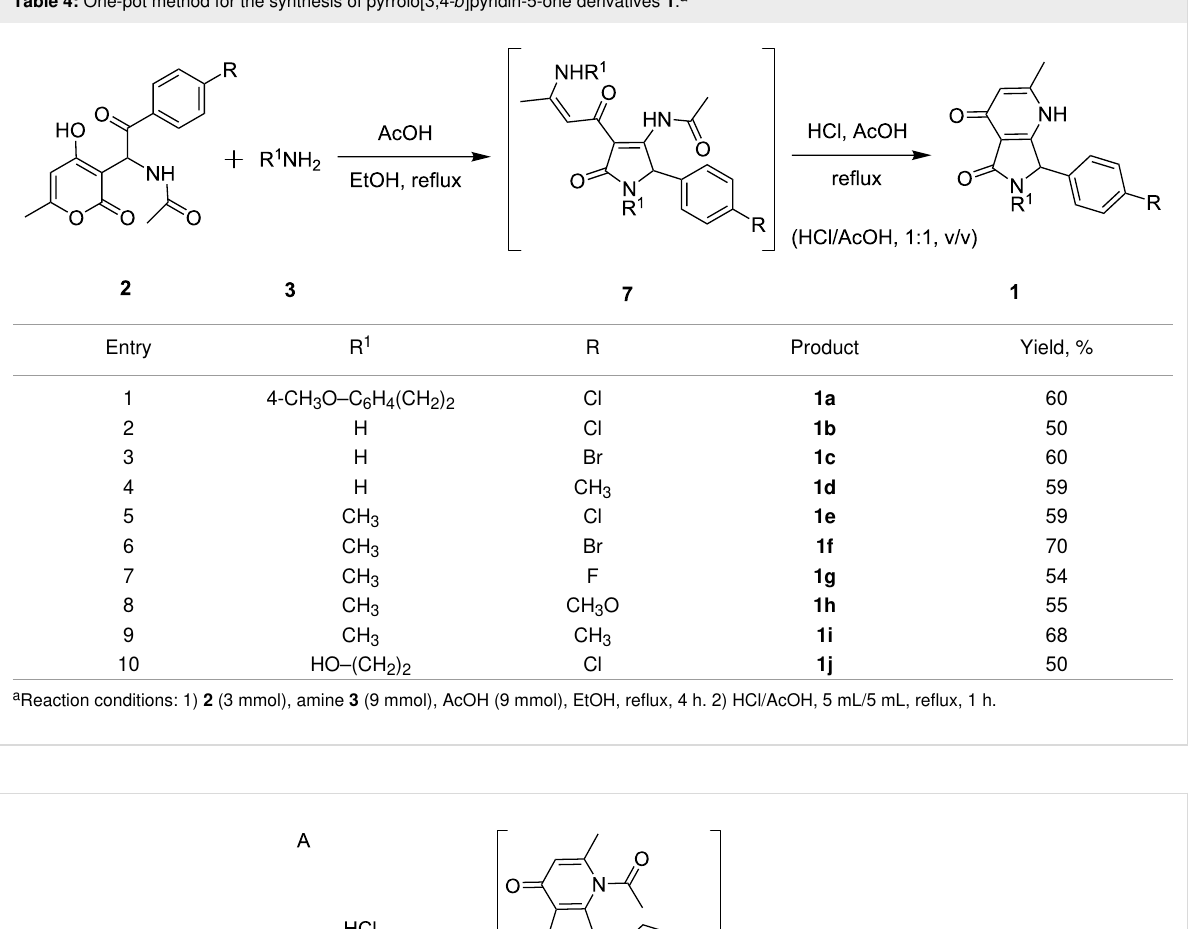
Table 4: One-pot method for the synthesis of pyrrolo[3,4- b ]pyridin-5-one derivatives 1 . a